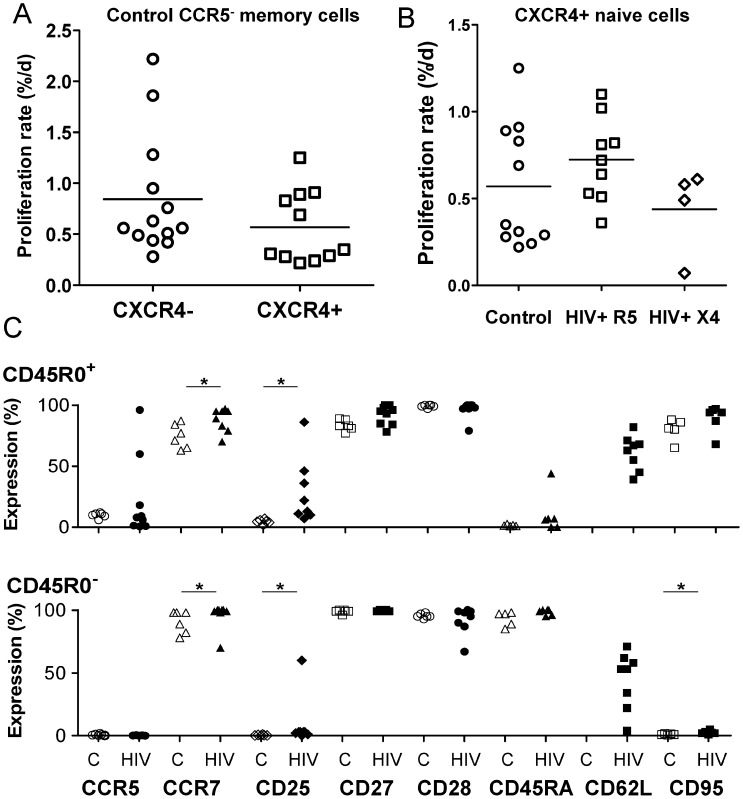
CXCR4 expression and turnover in CCR5− memory (CD45R0+) T-cells, CXCR4+ naïve (CD45R0−) T-cells and phenotypic correlates.(A) Proliferation rates in CXCR4− (circles) and CXCR4+ (squares) CCR5− CD45R0+ T cells in healthy controls; horizontal bars represent means, P = NS by t-test. (B) Modeled proliferation rates in CXCR4+ naive (CD45R0−) CD4+T cells from control subjects (circles), HIV-infected subjects with an R5-tropic virus (squares), and HIV-infected subjects with an X4-tropic virus (diamonds); horizontal bars represent means, P = NS by t-test. (C) Phenotype of CXCR4+ cells according to CD45 expression, either CD45R0+ (upper panel) or CD45R0− (lower panel). Values are shown from healthy control subjects (C, open symbols) and HIV+ subjects (H, closed symbols); * indicates significant difference between control and HIV data (P<0.05 by Mann Whitney test). CD62L data was not available for control subjects.